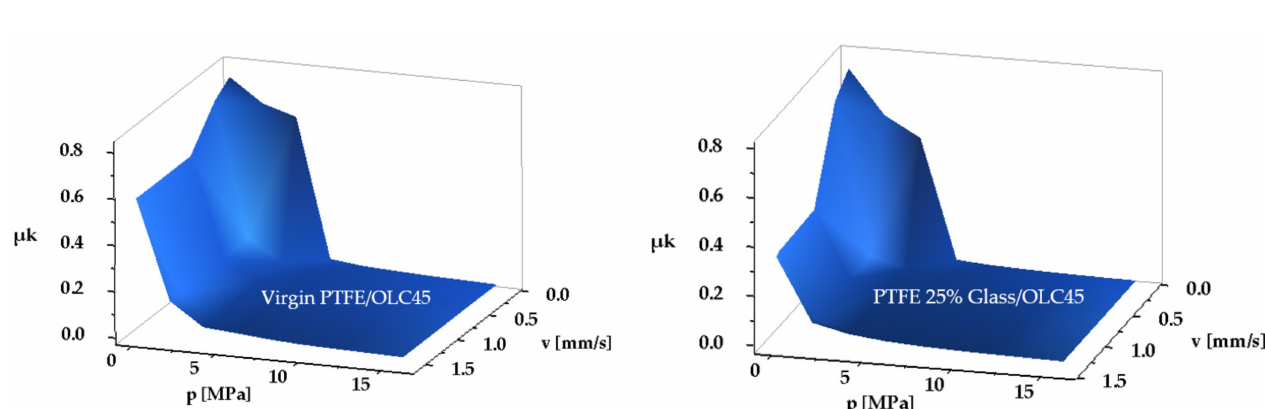
Figure 9. Dependency of the kinematic friction coefficient on contact pressure and